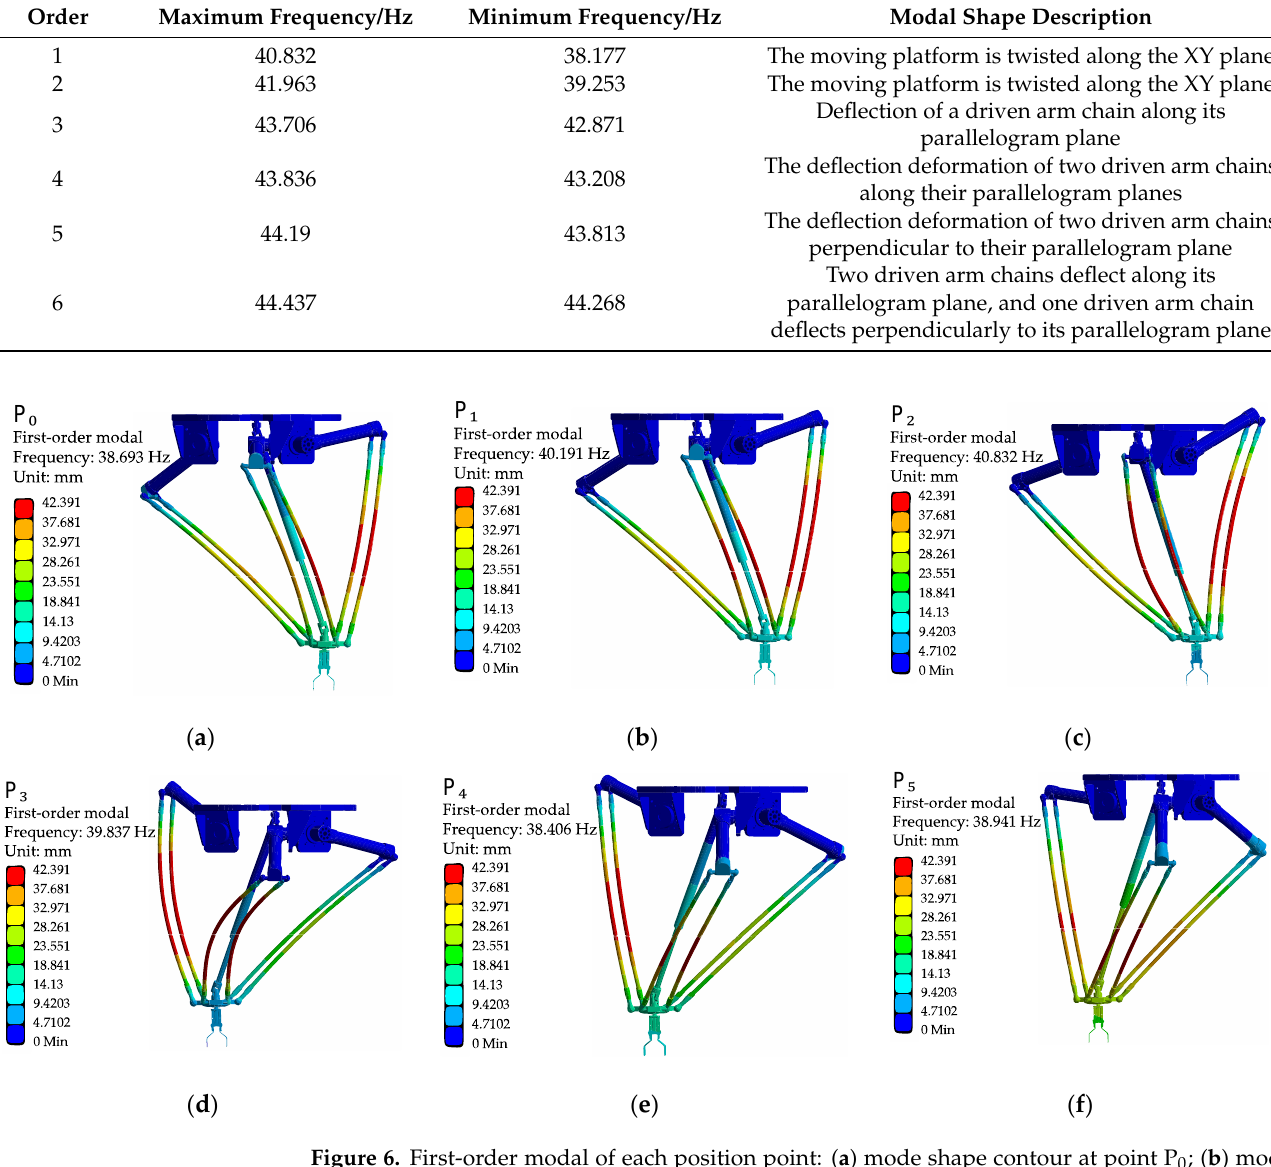
Table 4. Description of point vibration shapes of the robot at each position.